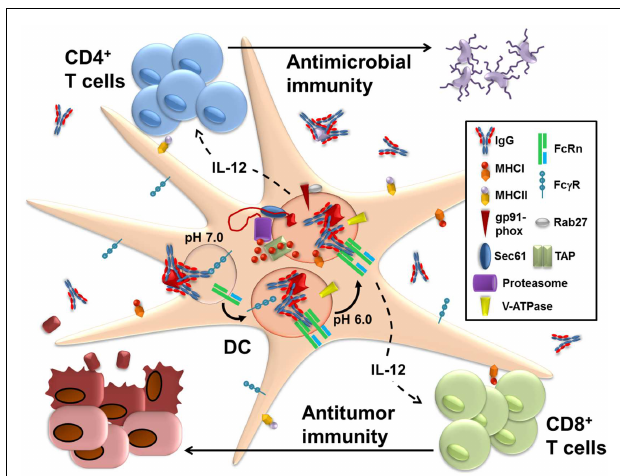
FIGURE 1 | FcRn within dendritic cells enables the presentation of IgG-complexed antigens to CD4 + T cells and CD8 + T cells . Following IgG opsonization of antigens from sources such as microbes or tumors, the immune complexes (IgG IC) bind to Fc γ R on the surface of dendritic cells (DC).This initiates receptor-mediated endocytosis, which delivers the IgG into the endolysosomal system of compartments. As these vesicles become more acidic during their maturation due to the recruitment of the vacuolar ATPase (V-ATPase), IgG IC dissociate from Fc γ R and bind instead to FcRn, which enables the subsequent trafficking of the IgG IC into antigen processing pathways that promote the generation of epitopes compatible with loading onto MHC class I and MHC class II. Machinery known to be involved in the presentation of soluble antigens for MHC class I processing and presentation, such as gp91-phox, Rab27, Sec61,TAP (transporter associated with antigen processing), and the proteasome, are all preferentially recruited to the IgG IC-containing intracellular vesicles upon ligation of FcRn. Less information is available on the compartments involved in FcRn-facilitated MHC class II restricted presentation and it remains unknown whether this occurs within the same intracellular compartment as MHC class I-restricted processing. Once at the surface, these peptide loaded MHC molecules are then able to prime CD8 + and CD4 + T cells, respectively. Furthermore, ligation of FcRn by IgG IC induces the production of IL-12 by the DC.The secreted IL-12 acts upon the primed CD4 + T cells to induceTh1 polarization and upon the CD8 + T cells to promote activation and cytotoxicity. FcRn within DC thus contributes to the activation of cell-mediated adaptive immune responses that contribute to pathogen eradication and tumor